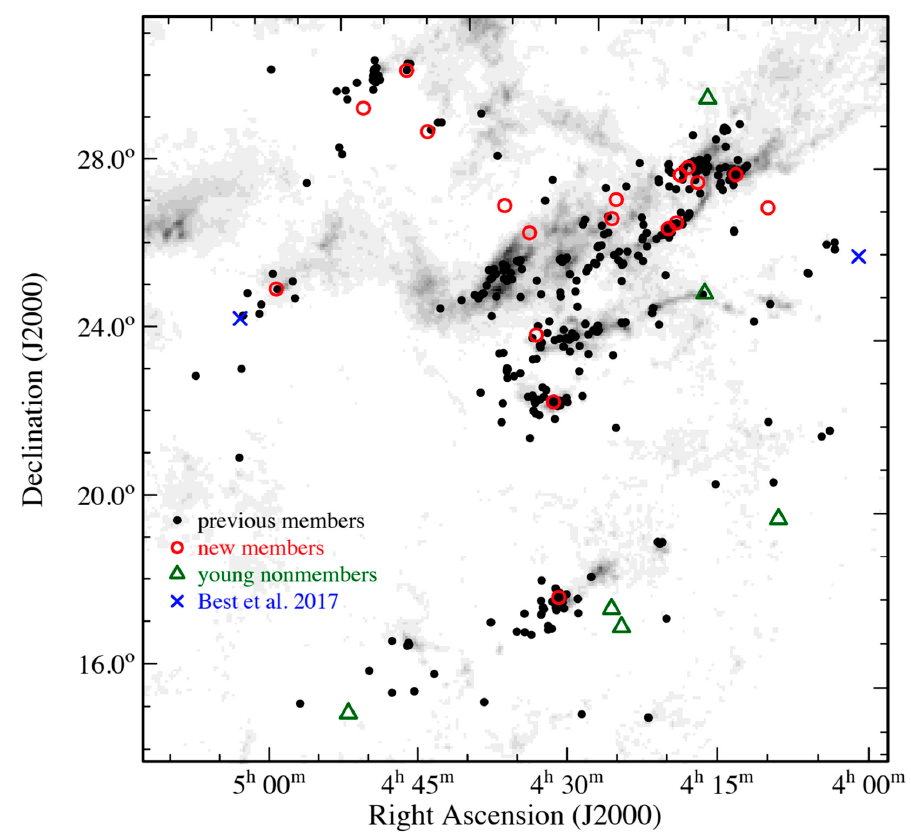
Figure 6. Spatial distribution of known members in Taurus. Black filled circles: members known before 2017; red open circles: new members from [189]; blue crosses: new members from [217]; green open triangles: young objects that do not appear to be members; grey scale: extinction map of [218]. Reproduced with permission from [189].